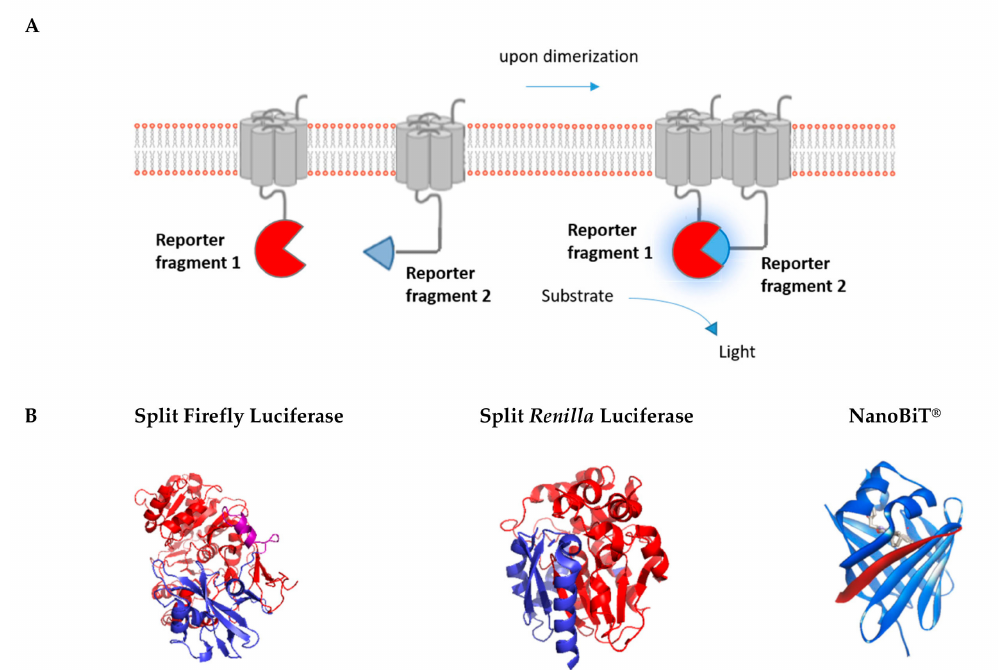
Figure 4. Luminescence-based protein complementation assay. ( A ) The principle of the luminescent complementation assay is shown schematically. ( B ) Split versions of the luminescent reporters Firefly, Renilla , and Nanoluciferase are shown in blue and red. Purple refers to overlapping sections. Split luminescent biosensors are depicted in proportion to their size (Fluc: 62 kDa, Rluc: 36 kDa, and NanoBiT ® : 19 kDa) (PDB Accession no. 1LCI for Firefly luciferase, PDB Accession no. 2PSD for Renilla luciferase) (NanoBiT ® : source